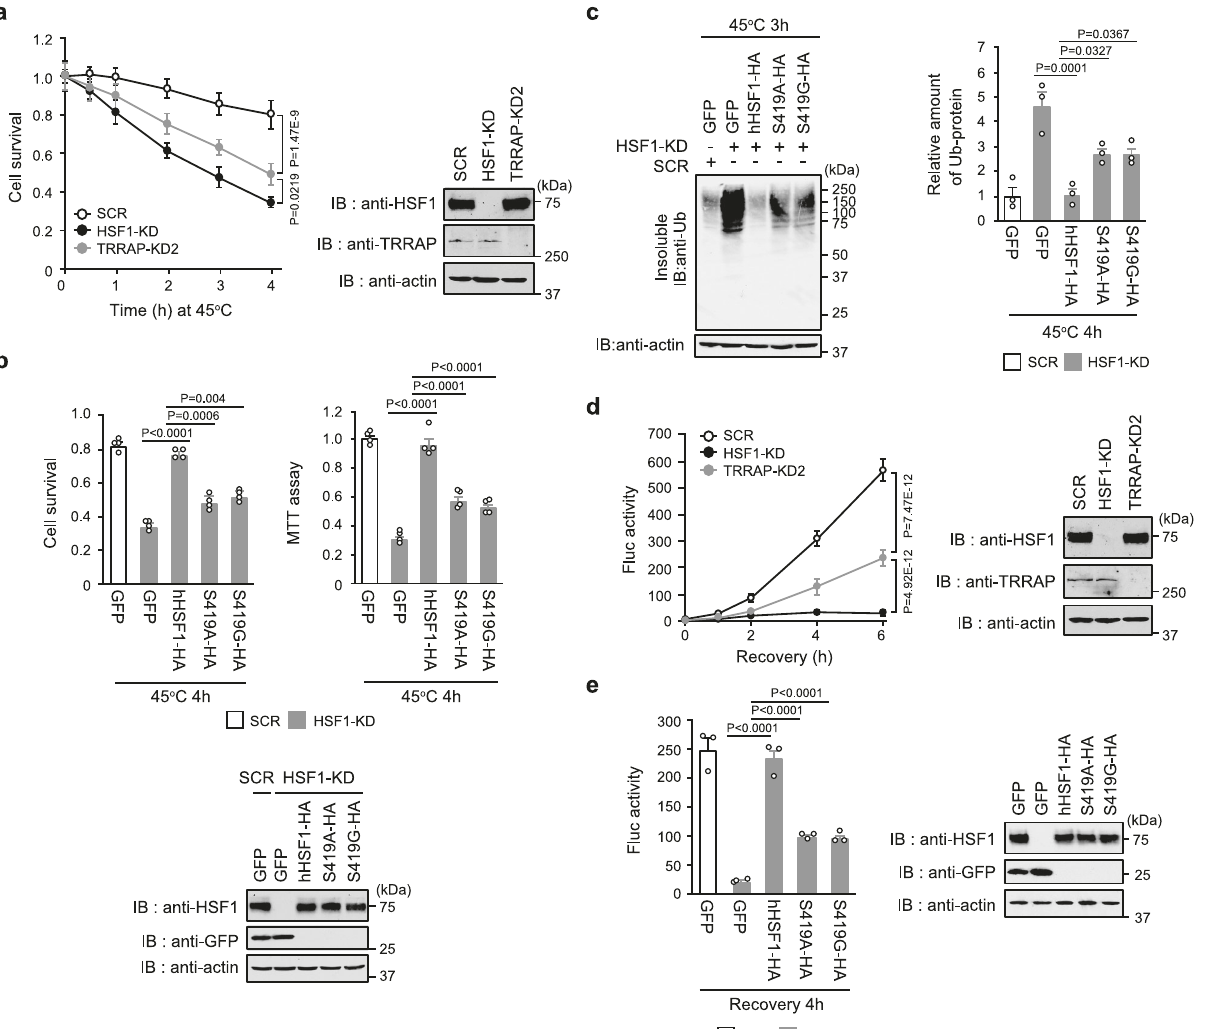
Fig. 6 | HSF1-S419 phosphorylation maintains proteostasis capacity. a TRRAP promotescellsurvival. Cellswereinfectedwithadenovirusexpressing shRNAfor HSF1, TRRAP or SCR, and were heat-shocked at 45°C for the indicated periods. Number of viable cells excluding trypan blue was counted. Extracts of cells were subjected to immunoblotting. b Phosphorylation of HSF1-S419 promotes cell survival. Cells, in which endogenous HSF1 was replaced with GFP, wild-type hHSF1-HA, or hHSF1-S419A mutants were heat-shocked at 45°C for 4h. Number ofviablecellsexcludingtrypanbluewascounted,andMTTassaywasperformed. Extracts of cells were subjected to immunoblotting. c Phosphorylation of HSF1- S419 inhibits the accumulation of ubiquitylated proteins. Cells treated as described in b were heat-shocked at 45°C for 4h. The accumulation of insoluble ubiquitylated proteins was examined by immunoblotting using anti-Ub antibody and quanti fi ed. β -Actin levels in the soluble fraction were also shown. d TRRAP